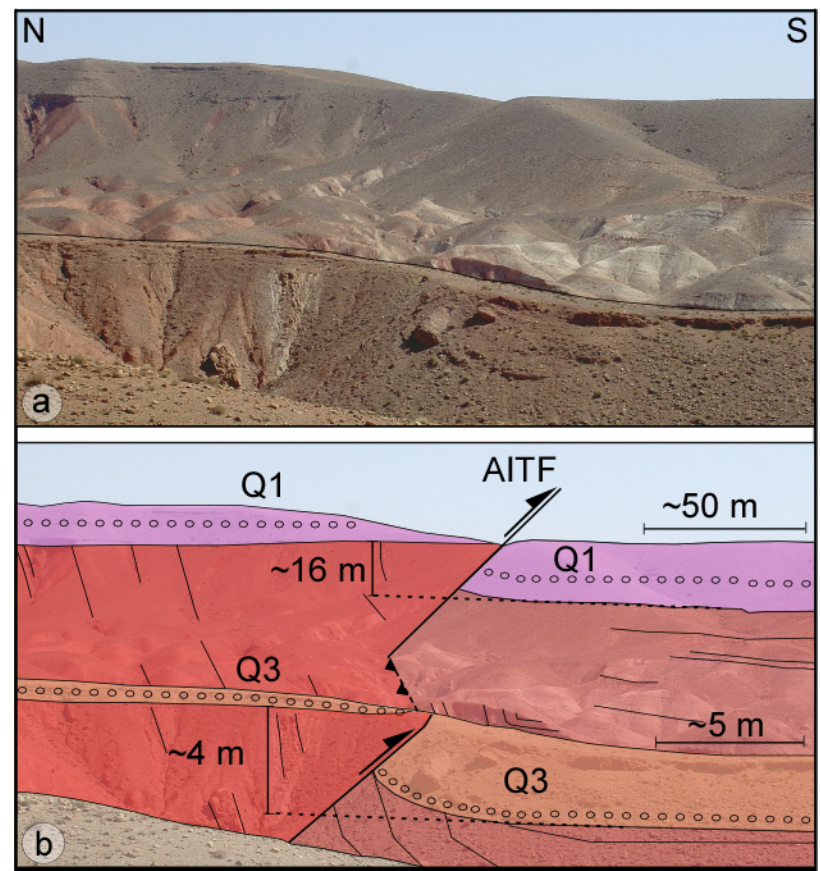
Figure 5. (a) Field image of the Amekchoud-Imidir thrust fault (AITF) in the Tabia area, looking from the west. (b) Interpretation of the image showing how the AITF reaches the surface and cuts the Quaternary deposits (Q1 and Q3). See location in Figures 2 and